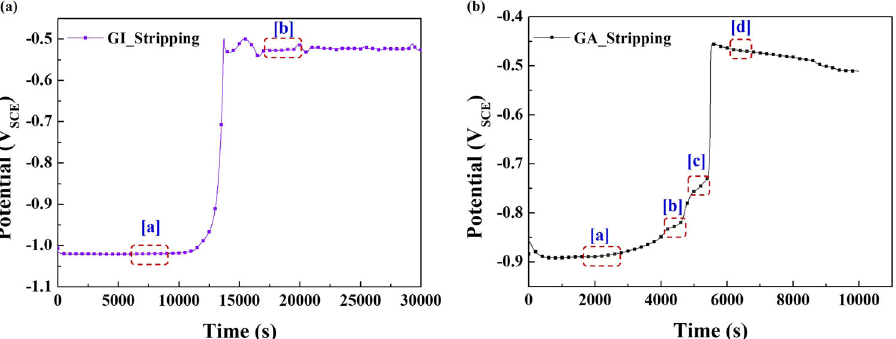
Fig. 5 Potential transition curves obtained from electrochemical stripping test in a 3.4 M NaCl + 0.3 M ZnSO 4 solution. a , b GI and GA, respectively.